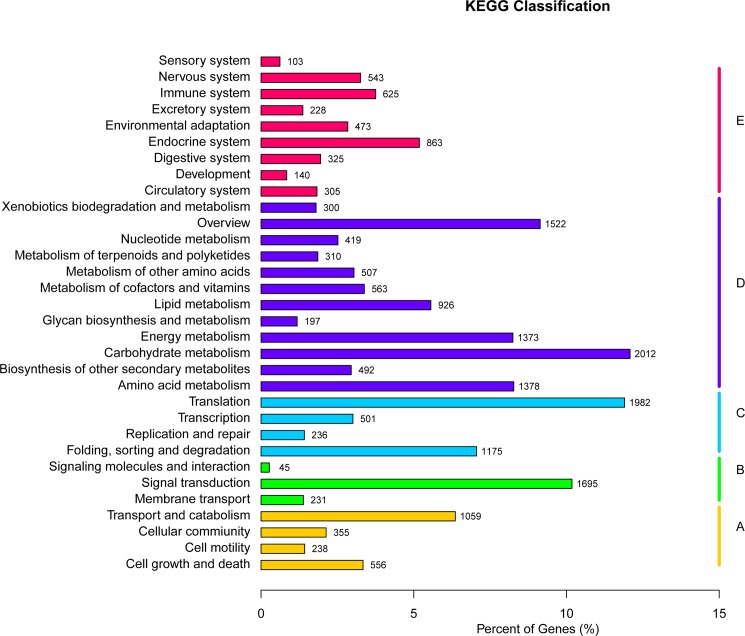
KEGG pathway classification of R. patientia unigenes.